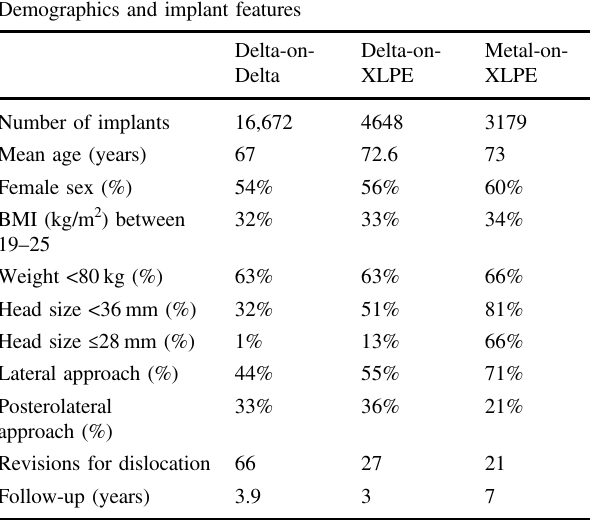
Table 2 Demographic and implant features of the most recent articulations